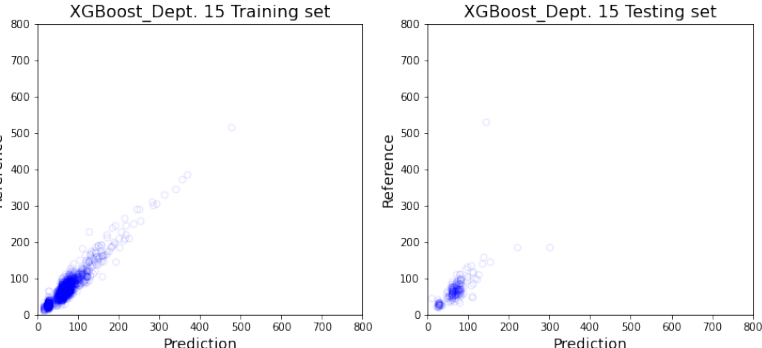
Figure A21. Model Performance of XGBoost on Dept.15. The visualization of training and testing data for department specific model on department 15 with